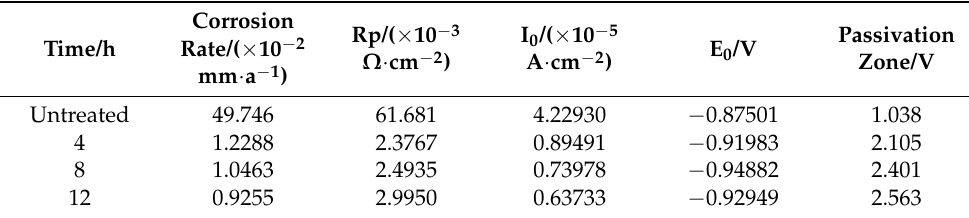
Table 2. Fitting data of the polarization curve of the modified layer of 3Cr13 steel after RE plasma nitriding at different